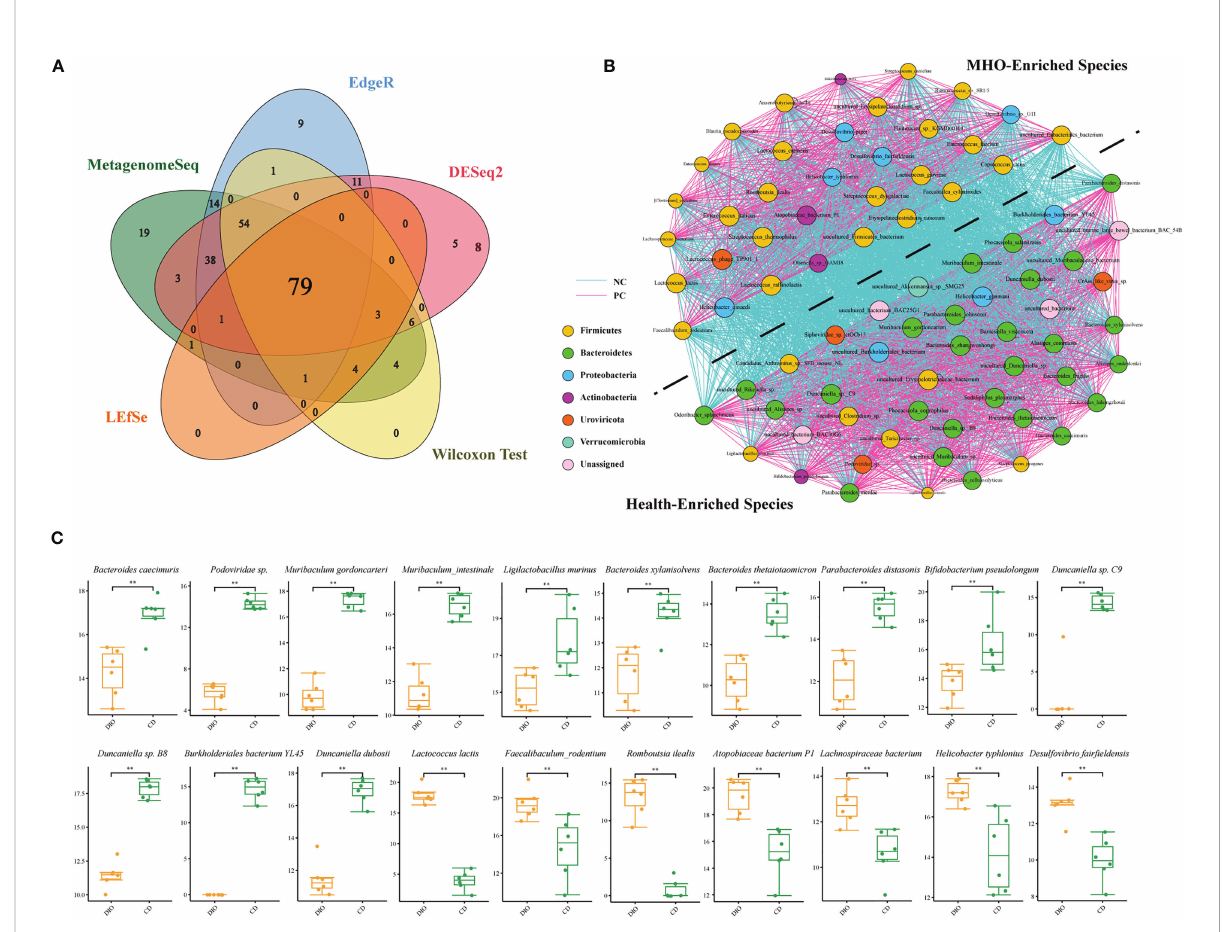
FIGURE 4 Signi fi cantly-changed species in MHO mice. (A) Venn diagrams illustrating 79 species commonly identi fi ed using fi ve different algorithms (MetagenomeSeq, EdgeR, DESeq2, LEfSe, and Wilcoxon Test). (B) Co-occurrence network visualization of the interactions among the above species. The lines connecting nodes (edges) represent a positive (light blue) or negative (pink) co-occurrence relationship. The color of each dot represents the different taxonomic af fi liations of the species (phylum level), and the size corresponds to their relative abundance. (C) For some representative species among the above 79 species, the difference in abundance was compared using the Mann-Whitney U test. * p 0.05 ** p